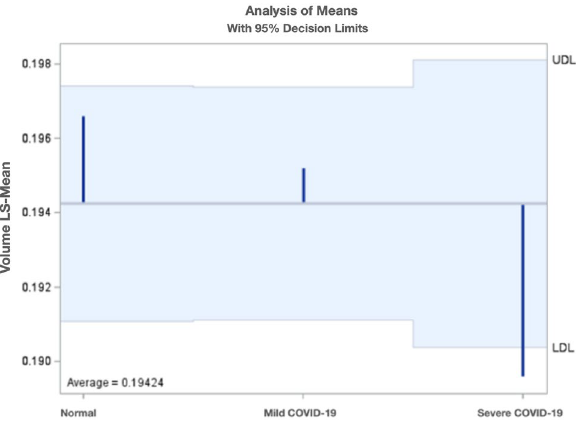
Figure 5. Least square means of the volume from the outer four standard ETDRS sectors stratified by COVID- 19 severity. ETDRS Early treatment diabetic retinopathy study, COVID-19 Coronavirus